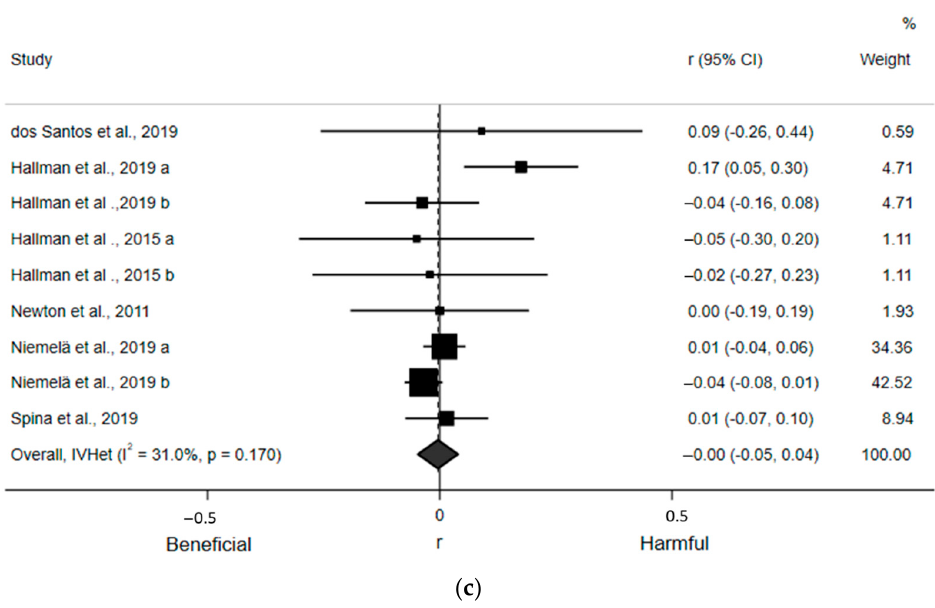
Figure 4. Forest plots of articles examining the association between ST and frequency domain indices of HRV. ( a ) Association between ST and LF. ( b ) Association between ST and HF. ( c ) Association between ST and LF/HF ratio.